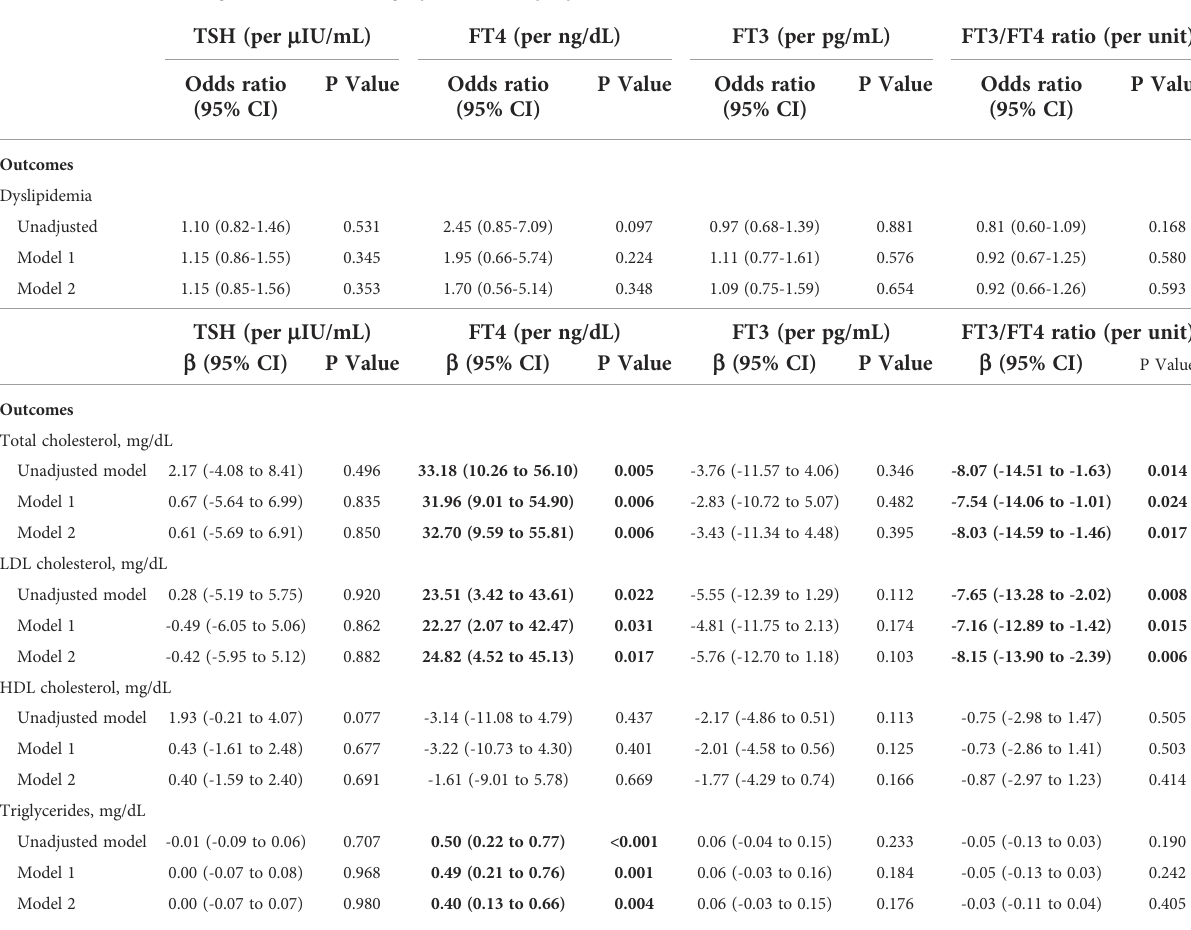
TABLE 4 Association of thyroid function with dyslipidemia and lipid pro fi